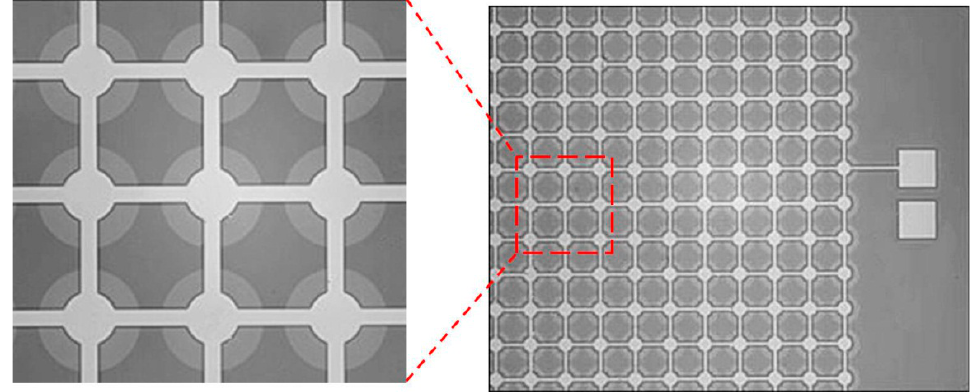
Figure 6. The infrared images of CMUT array.